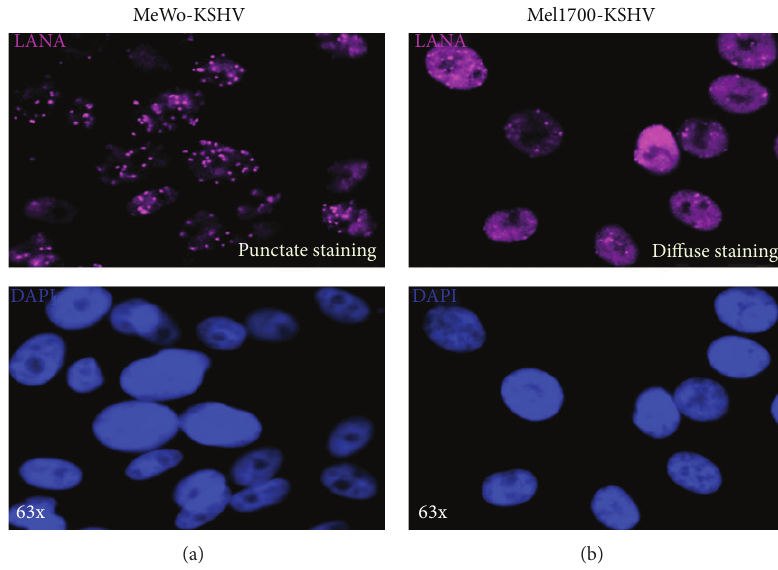
Figure 4: Differential expression of LANA in KSHV-infected MeWo and Mel1700 cells reveals diffuse nuclear staining as a marker of spontaneous or drug-induced lytic replication. Infected MeWo-KSHV (a) and Mel1700-KSHV cells (b) were plated in chamber slides and allowed to adhere overnight, then fixed, permeabilized, and stained with the LANA-specific LN35 primary antibody, followed by chicken anti- rat secondary antibody conjugated to Alexa-Fluor-647 (Cy5). Shown are 63x magnification (oil immersion) images of infected MeWo-KSHV (a) and Mel1700-KSHV cells (b) showing LANA (top image) along with the corresponding DAPI nuclear counter-stain (bottom image), respectively. Note the predominantly discrete “punctate” LANA staining in MeWo-KSHV cells (a) in contrast to the more diffuse LANA staining in almost all Mel1700-KSHV cells (b).